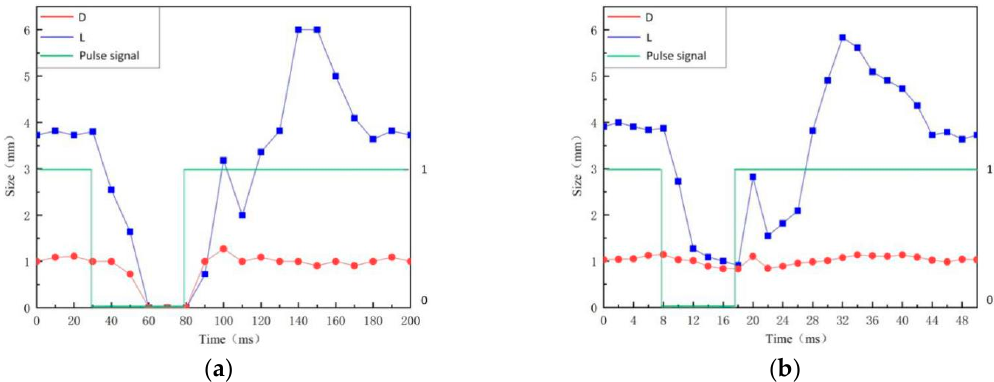
Figure 8. Arc core region size of PPG-VPPAW. ( a ) PPG-VPPAW (4 Hz); ( b ) PPG-VPPAW (20 Hz).